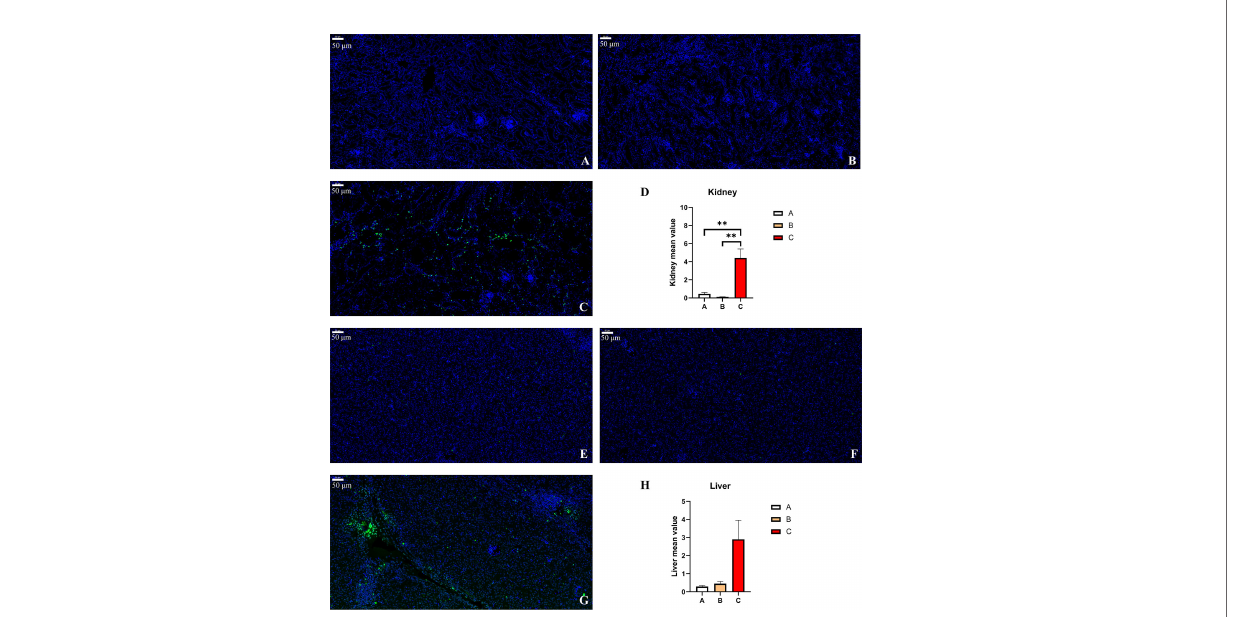
FIGURE 9 | TUNEL staining and fl uorometry of the pullets ’ kidney and liver after 42-day trial. Groups A, B, and C are the control group, the pair-feeding group, and the OTA+AFB1 group, respectively. (A) Kidney of Group A, ×20. (B) Kidney of Group B, ×20. (C) Kidney of Group C, ×20. (D) Detection of caspase-3 enzyme activity by fl uorometry in chick kidney (n = 3, mean ± SEM, ** p < 0.01). (E) Liver of Group A, ×20. (F) Liver of Group B, ×20. (G) Liver of Group C, ×20. (H) Detection of caspase-3 enzyme activity by fl uorometry in chick liver (n = 3, mean ± SEM). OTA, ochratoxin A; AFB1, a fl atoxin